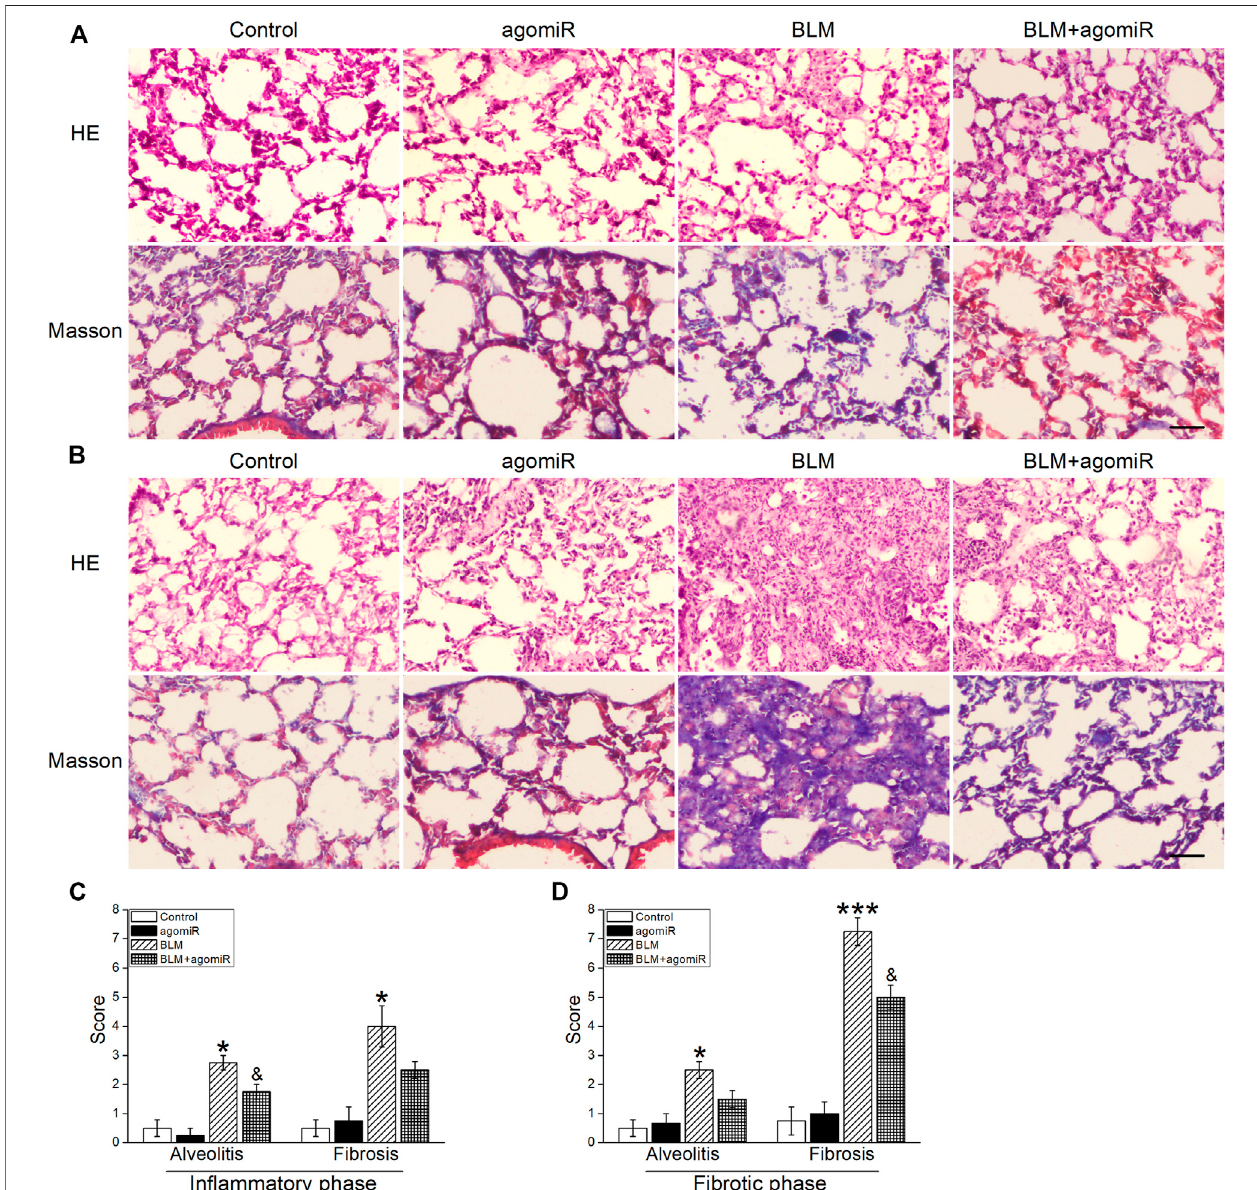
FIGURE 5 | MiR-130a-3p agomiR offsets BLM-induced structural damage in the mouse lung. Pathologic change of lung tissues evaluated by H&E and Masson ’ s trichromestaininginthe (A) in fl ammatoryphaseand (B) fi broticphaseafterBLMinduction.Scalebar=50 μ m.Alveolitisand fi brosisscoresofthelungsectionsinthe (C) in fl ammatory phase and (D) fi brotic phase. * p < 0.05, *** p < 0.001, versus the control group; & p < 0.05, versu s the BLM group, by the Mann – Whitney U test, n = 4 – 5.